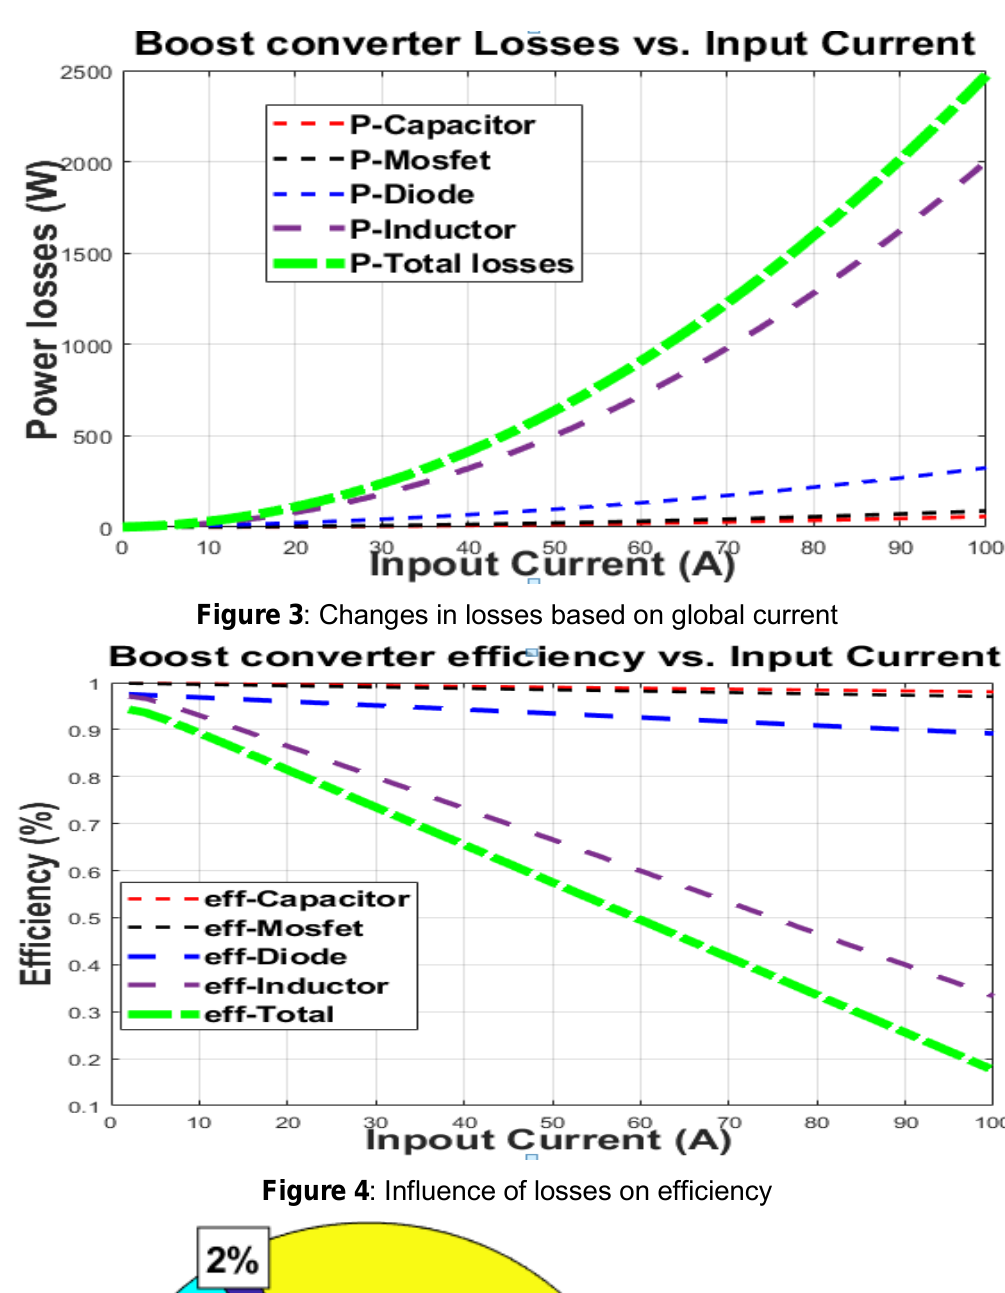
Figure 4 : Influence of losses on